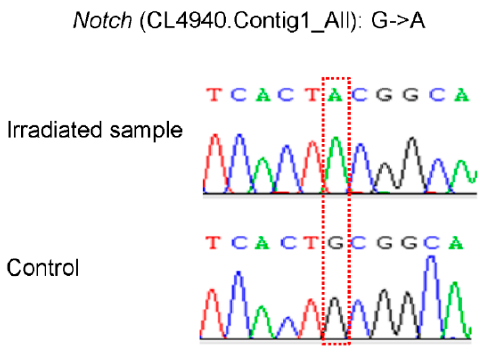
Figure 5. Sanger sequencing results for the SNP identified in the Notch gene.